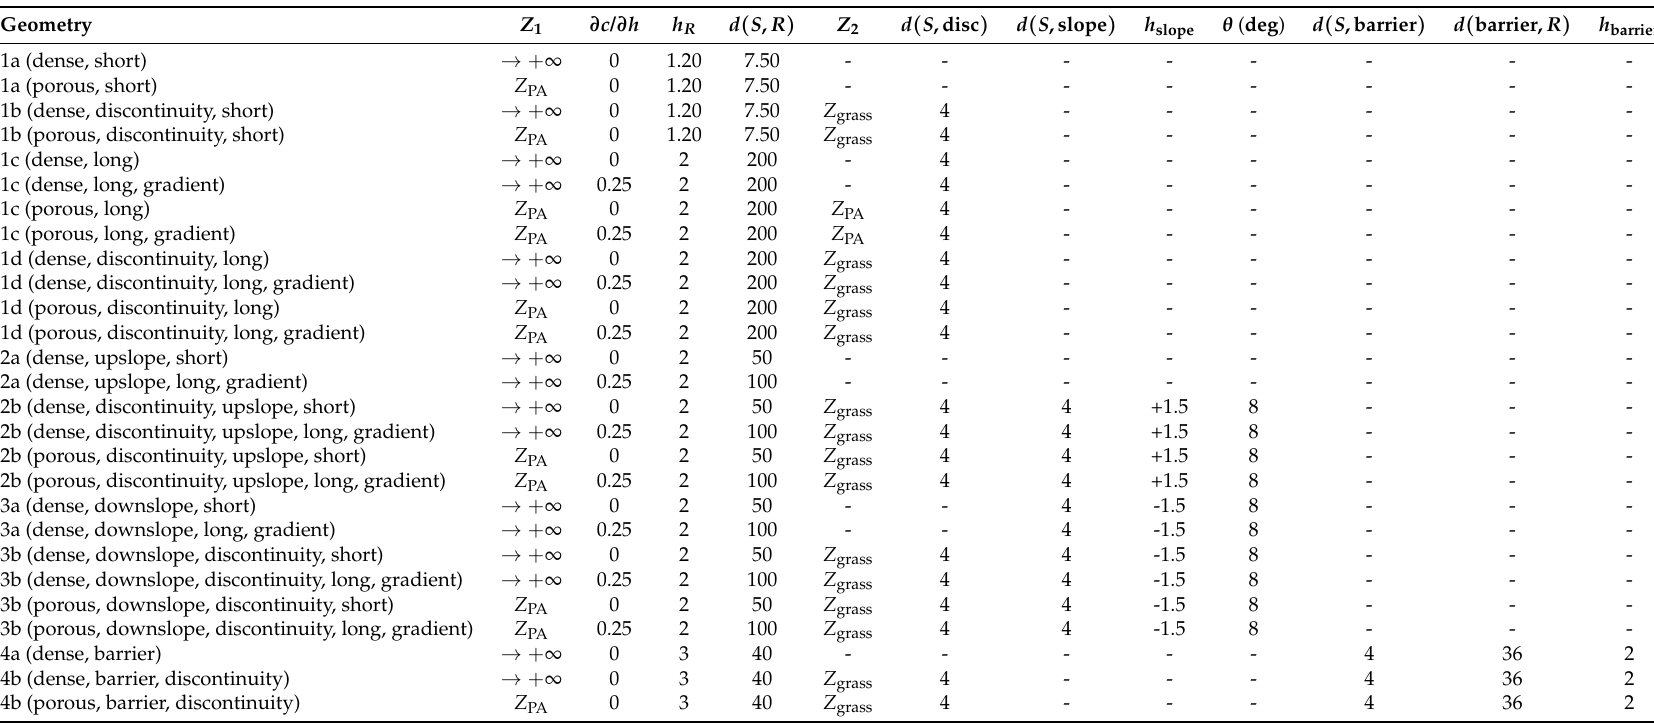
Table 1. Geometrical road configurations. Distances d and heights h are given in meters (m). Propagation above a ‘dense’ ( Z → + ∞ ) or ‘porous’ ( Z PA ) pavement,